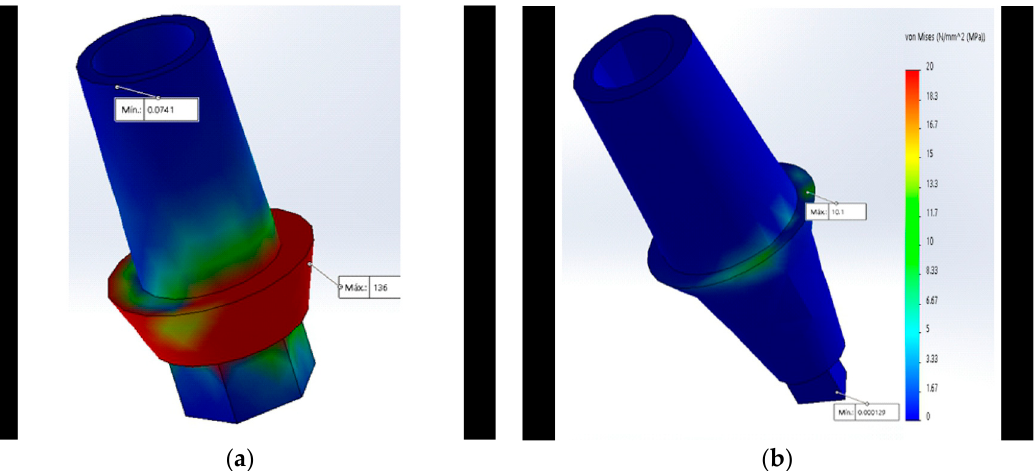
Figure 4. Maximum stress with 350 N at the abutment is represented by the red color using the von Mises scale: ( a ) Maximum stress at the neck in the IH connection; ( b ) maximum stress at the neck in the CT was lower (represented by the green color).